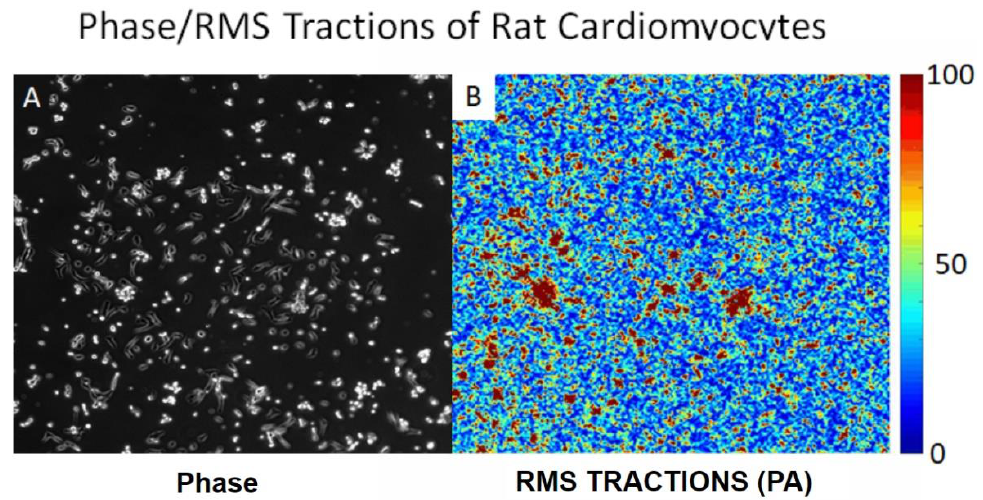
Figure 9. ( A ) Phase image of rat cardiomyocytes on 1200 kPa stiffness hydrogel. ( B ) 2D map of tractions exerted by the cells on their substrate.